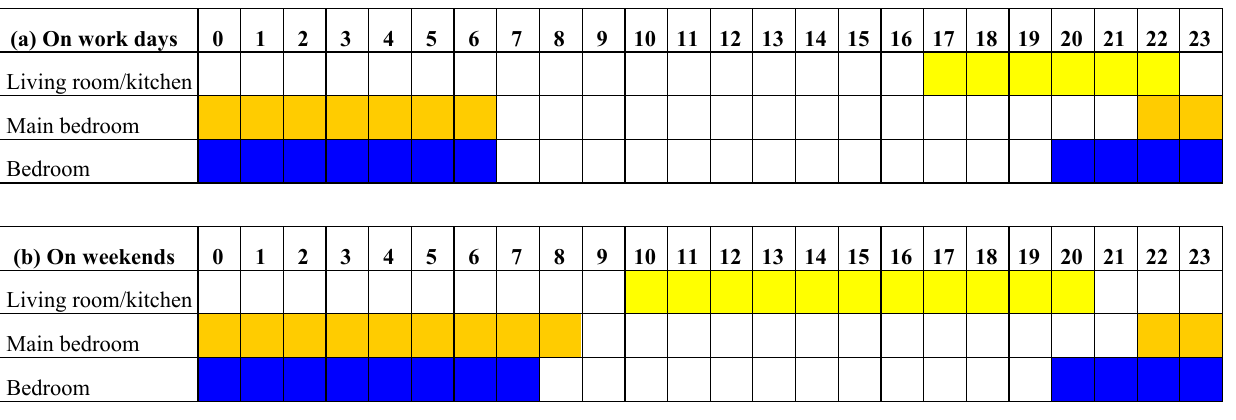
Figure 3. Daily occupation period of major spaces (00:00 to 23:00).